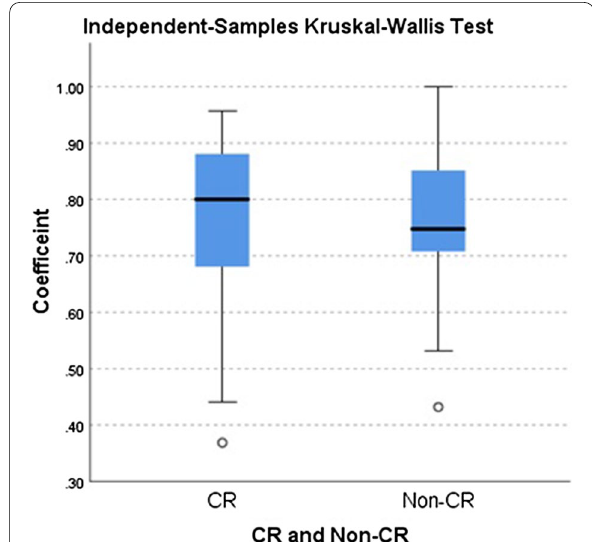
Fig. 6 Box plots of the relationship between central vs peripheral lesions and the CR and non-CR groups, no significant difference ( P .62)